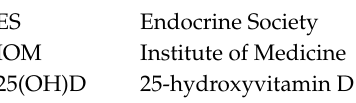
Figure S1: Weighted logistic regression for selected predictors of vitamin D deficiency (IOM < 30 nmol / L) in ELSA study participants, Table S1: Participant characteristics stratified by vitamin D deficiency (IOM and ES), Table S2: Serum 25(OH)D status by region in England, findings from the ELSA Study ( n = 6004). Prevalence (%) vitamin D deficiency (IOM, < 30 nmol / L) and vitamin D deficiency (ES, < 50nmol / L), stratified by season a and region. Table S3: Weighted logistic regression for predictors of vitamin D deficiency ( < 50 nmol / L) in ELSA study participants ( n =